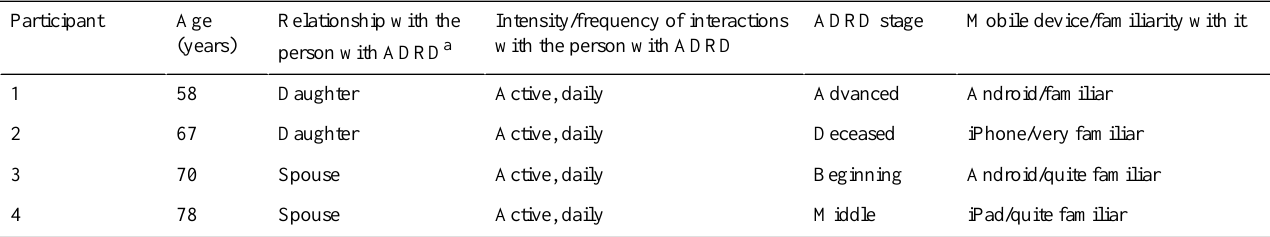
Table 1. Characteristics of focus group participants